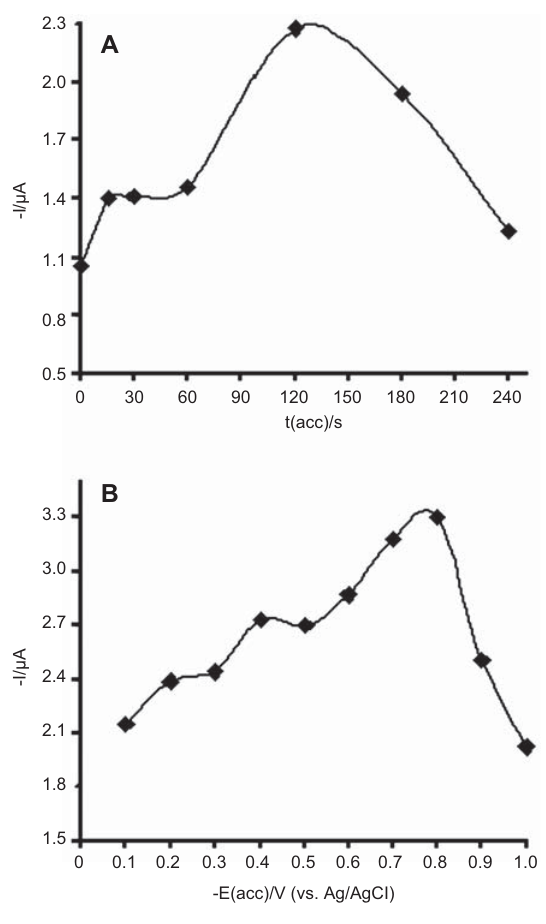
Figure 3 The effect of accumulation variables on the stripping signals for 40 µ m ABA solution in phosphate buffer, pH 3.0 (with 0.02 m NaCl). Electrode, pencil-lead BiFE; SWV parameters as indi- cated in Figure